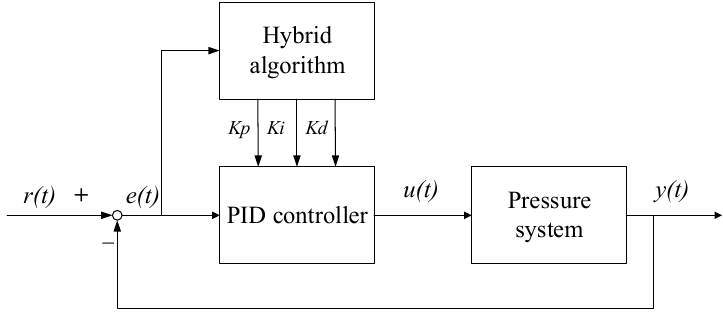
Figure 2. Block diagram for the proportion integration differentiation (PID) control system design improved particle swarm algorithm (PSO) algorithm.